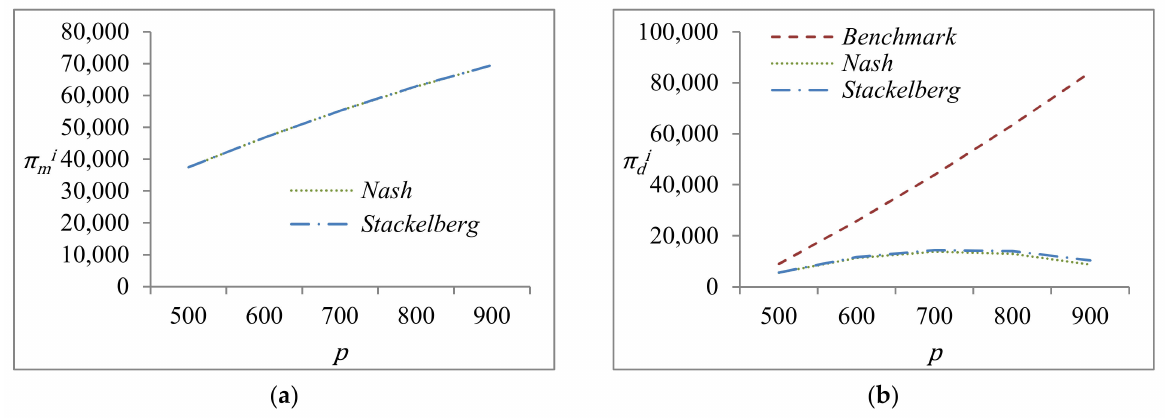
Figure 4. Effect of selling price on: ( a ) manufacturer’s profit; ( b ) retailer’s profit. The following market condition is used: r = 0.2, r r = 0.2, ε = 0.005, h = 30, α m = α o = α r = 100, γ = 0.9, γ r = 0.2, p = variable , v r = 400, v o = 20, c d = 420, c m = 100, ∅ = 3.